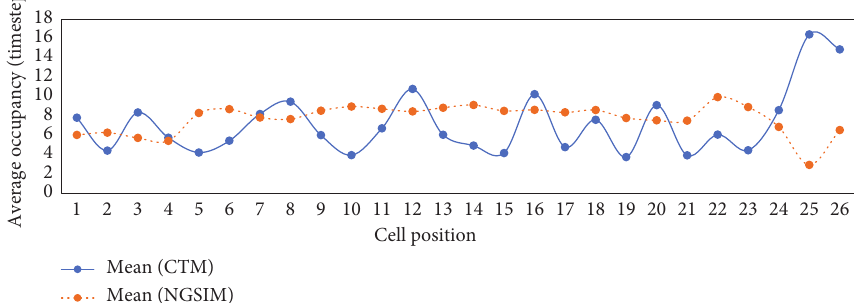
Figure 12: Comparison of the average occupancies/total time duration in each cell found between CTM and I80.